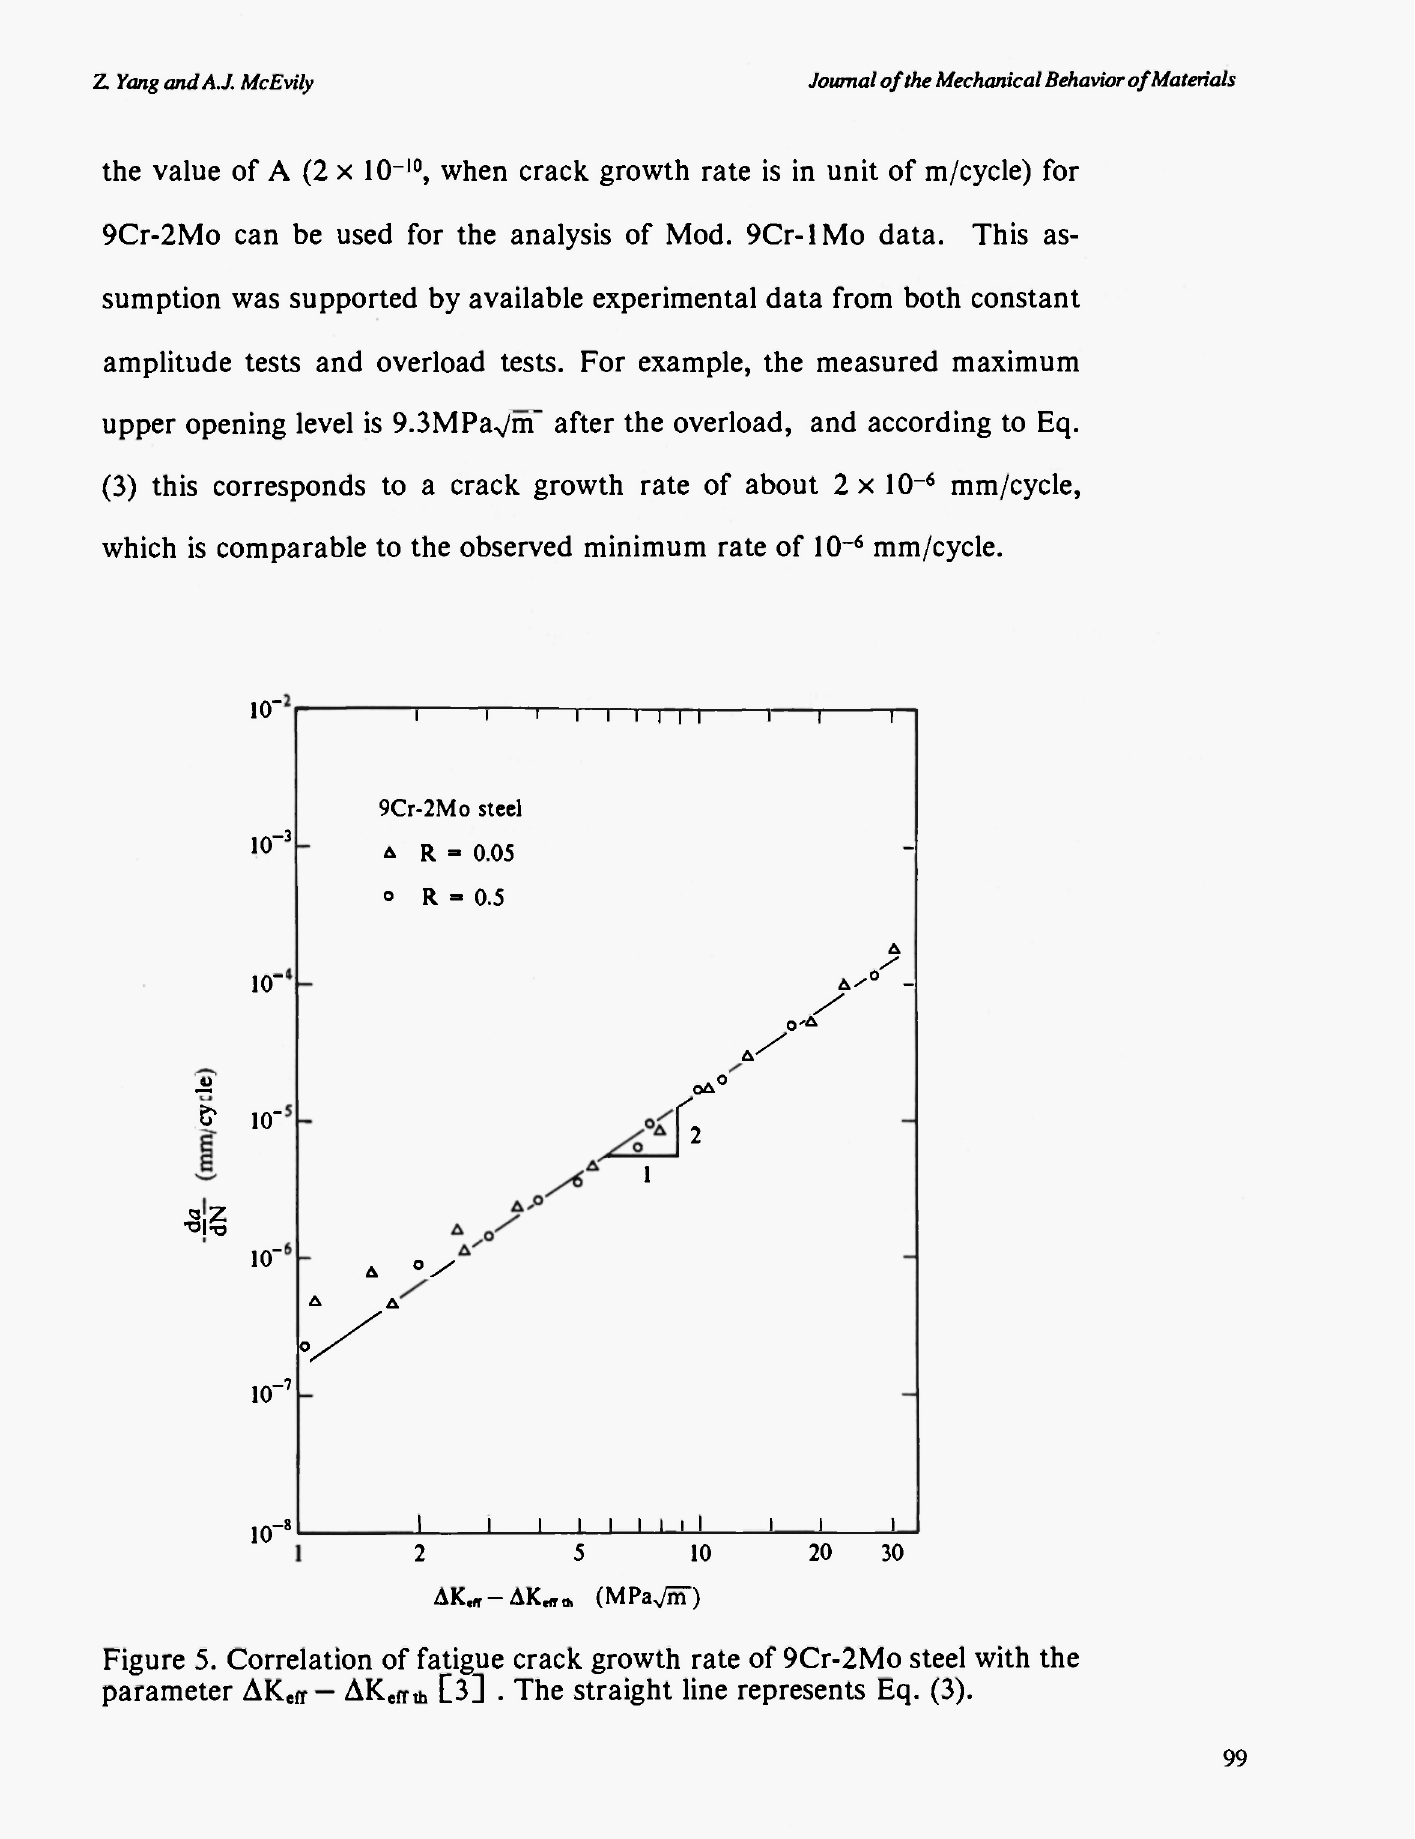
Figure 5. Correlation of fatigue crack growth rate of 9Cr-2Mo steel with the parameter AK r- AK h [ 3] . The straight line represents Eq. ef efTt